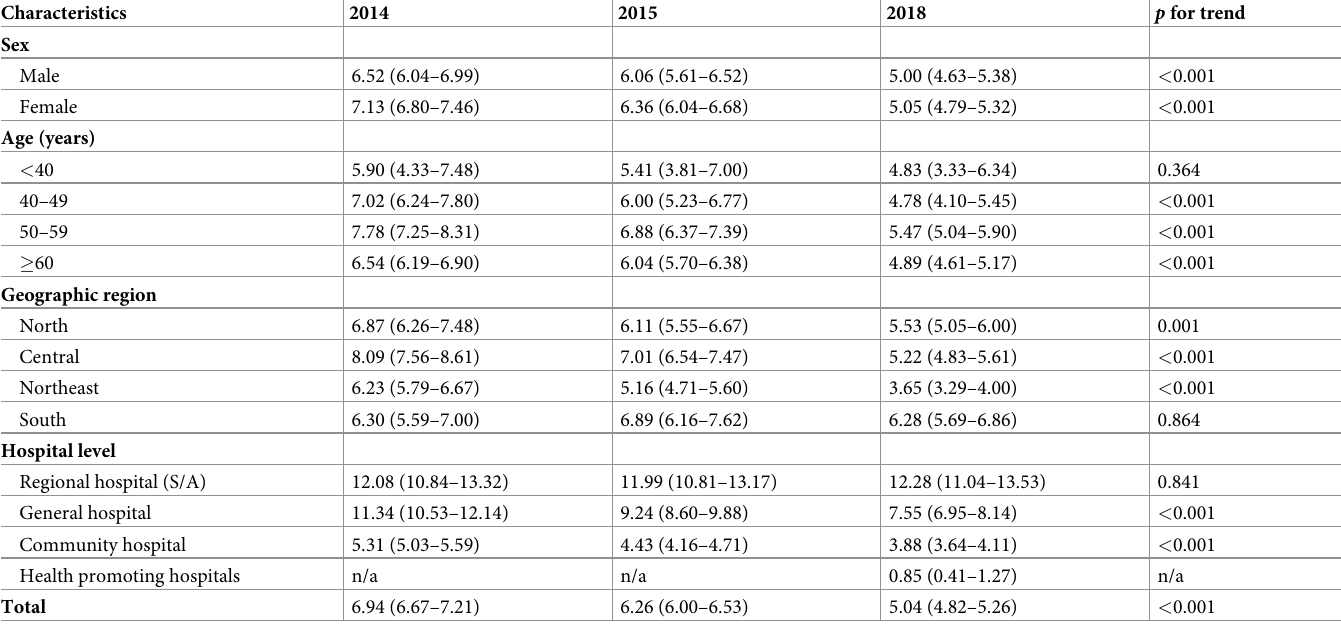
Table 2. Trends in the prevalence of diabetic retinopathy (DR) among Thai patients with T2D, 2014–2018.